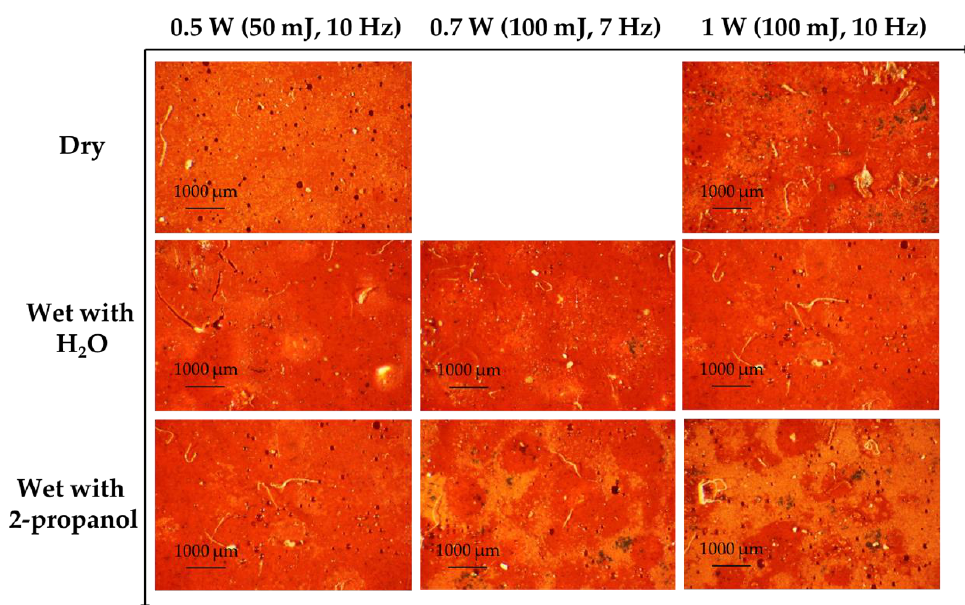
Figure 11. The microscopic images (32 × ) of the eight sections of mastic varnished cinnabar tempera mock-ups after different laser cleaning conditions and